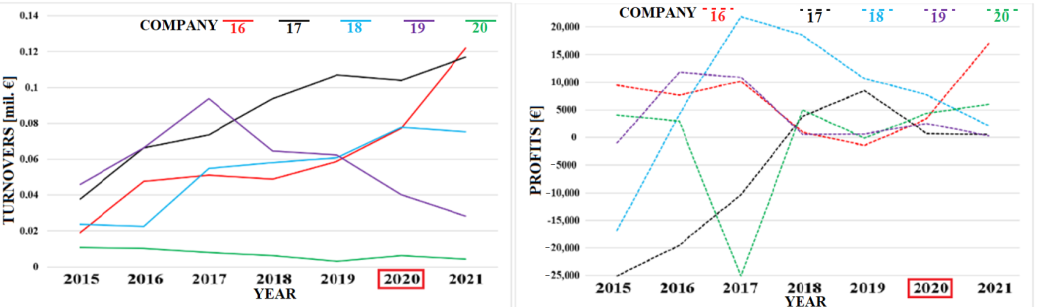
Figure 7. Development of turnovers and profits of the wine companies with turnovers of EUR 0.01 to 0.12 million annually [56].